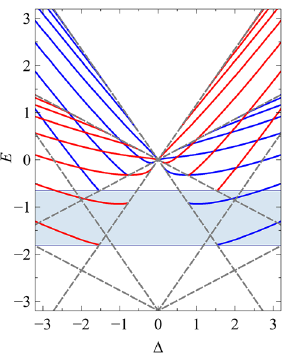
V 0 / cosh ( x ′ ) , of = − 1 and s 1 chirality (i.e., the K and K ′ valley in the effective = = − 0 and = 0.86 v F , v 0.32 v F . The boundary 0.69 v F and v t = y = =